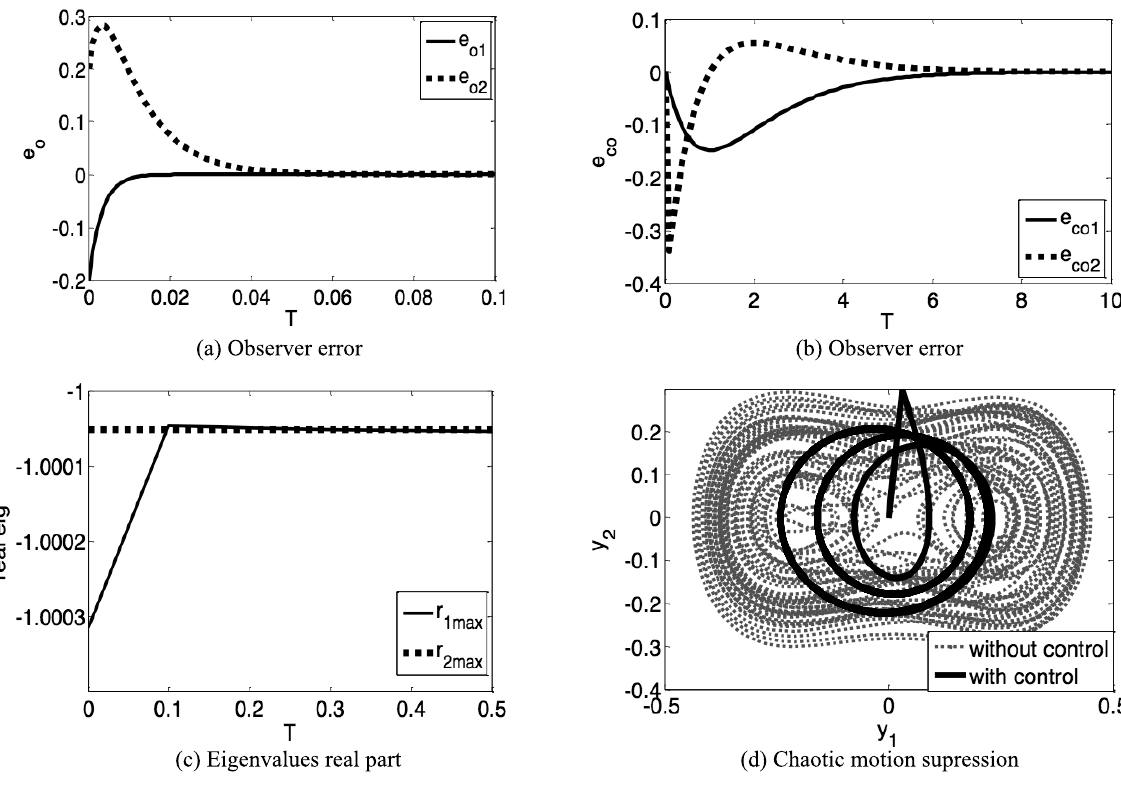
Fig. 5. State observer controle simulation